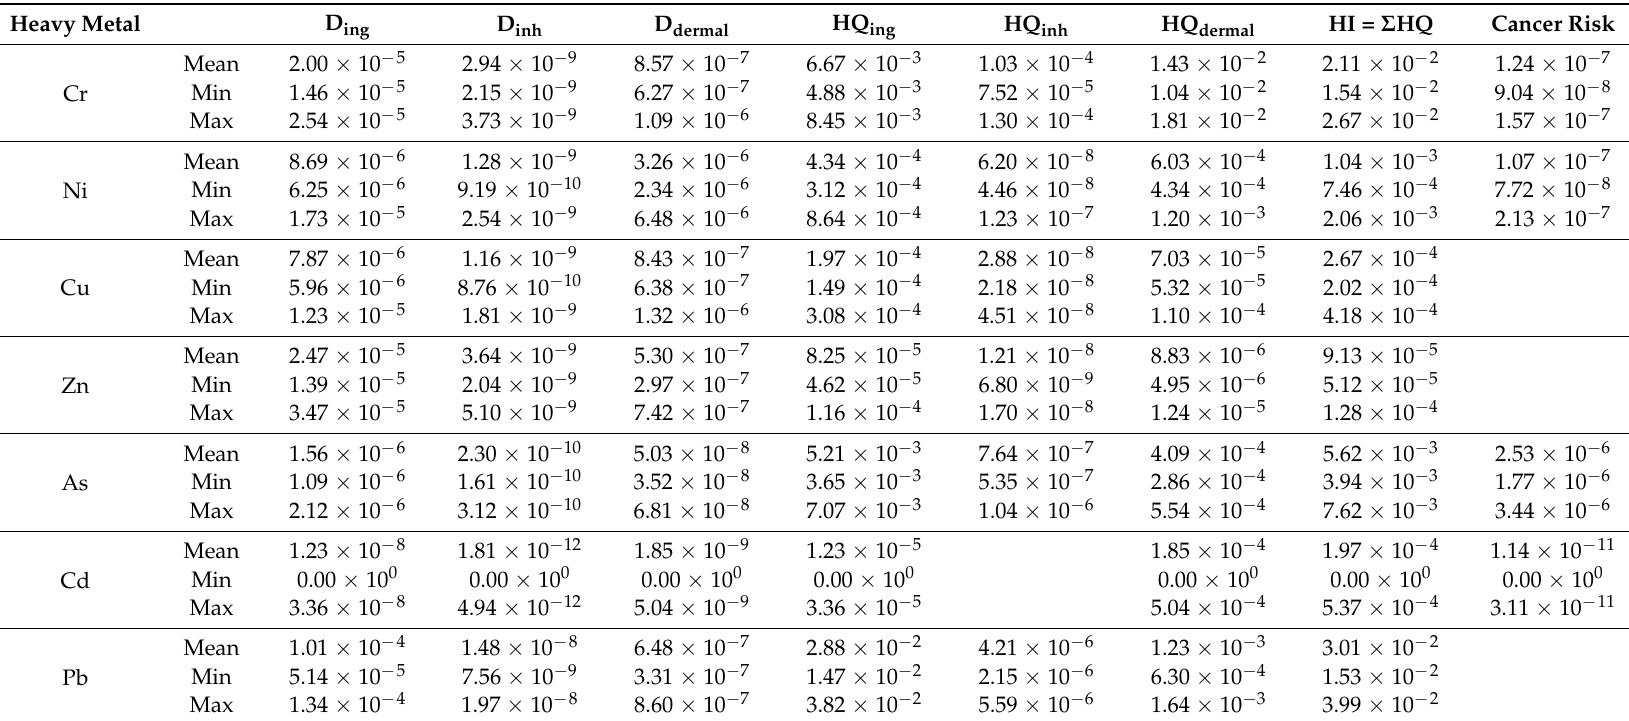
Table 5. Daily doses, hazard quotients, hazard indices, and cancer risks of heavy metals for adults. Heavy